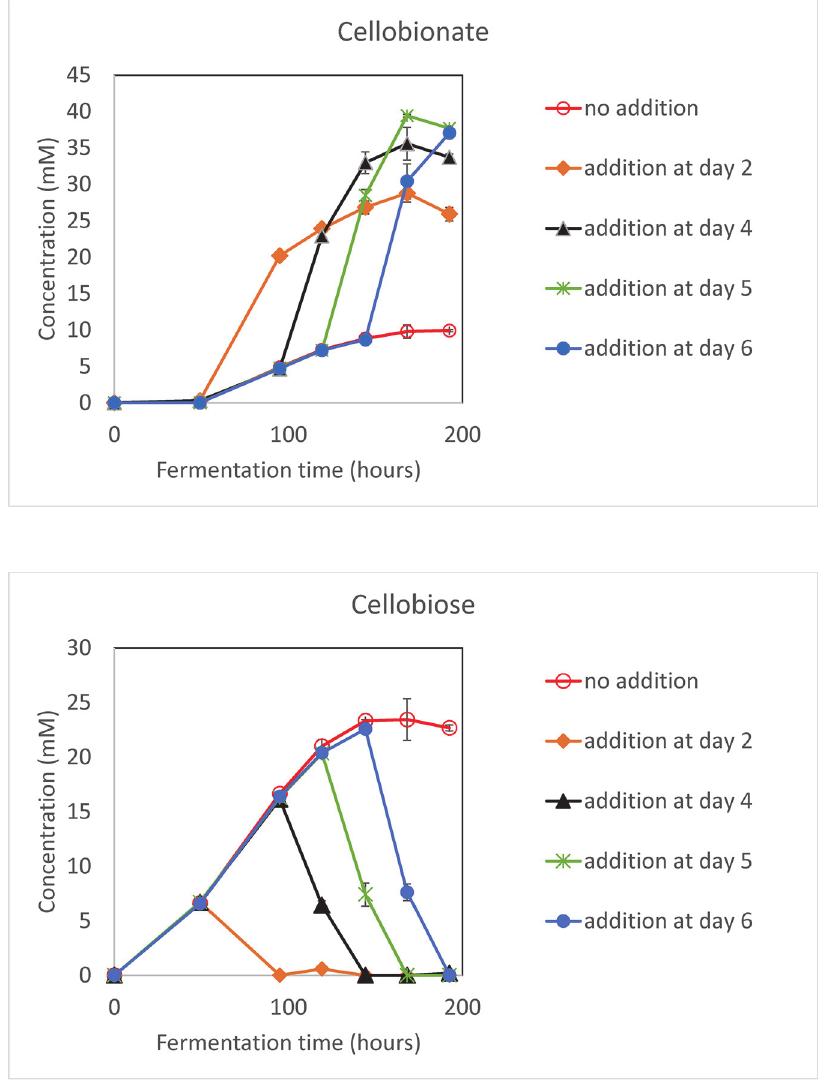
Fig 4. Optimization of laccase (0.05 U/mL) and ABTS (0.01 mM) addition time with the F5 Δ ace-1 Δ cre- 1 Δ ndvB strain grown in 1x Vogel ’ s medium and 20 g/L Avicel. The values shown are the means of biological triplicates with the error bars representing the standard